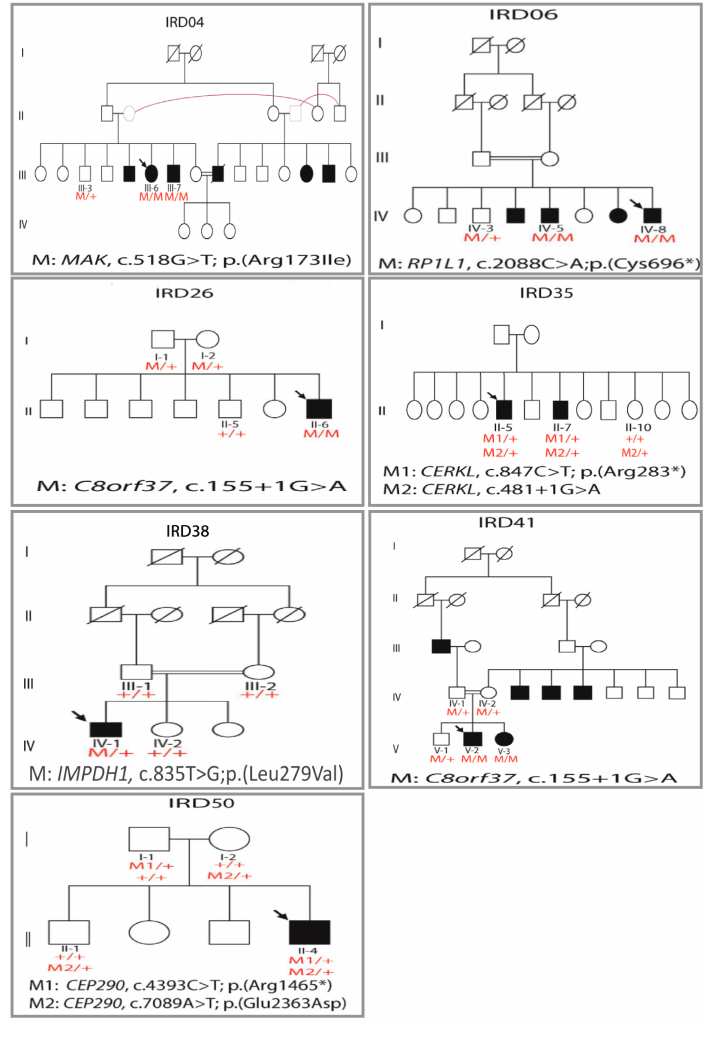
Figure 2. Pedigrees of families with identified novel potential disease-causing variants. Arrows indicate probands. Affected individuals are indicated with filled symbols, unaffected relatives are indicated by open symbols, consanguinity is marked by double lines and pink connected symbols signify the same person. M: mutation; +: wild type